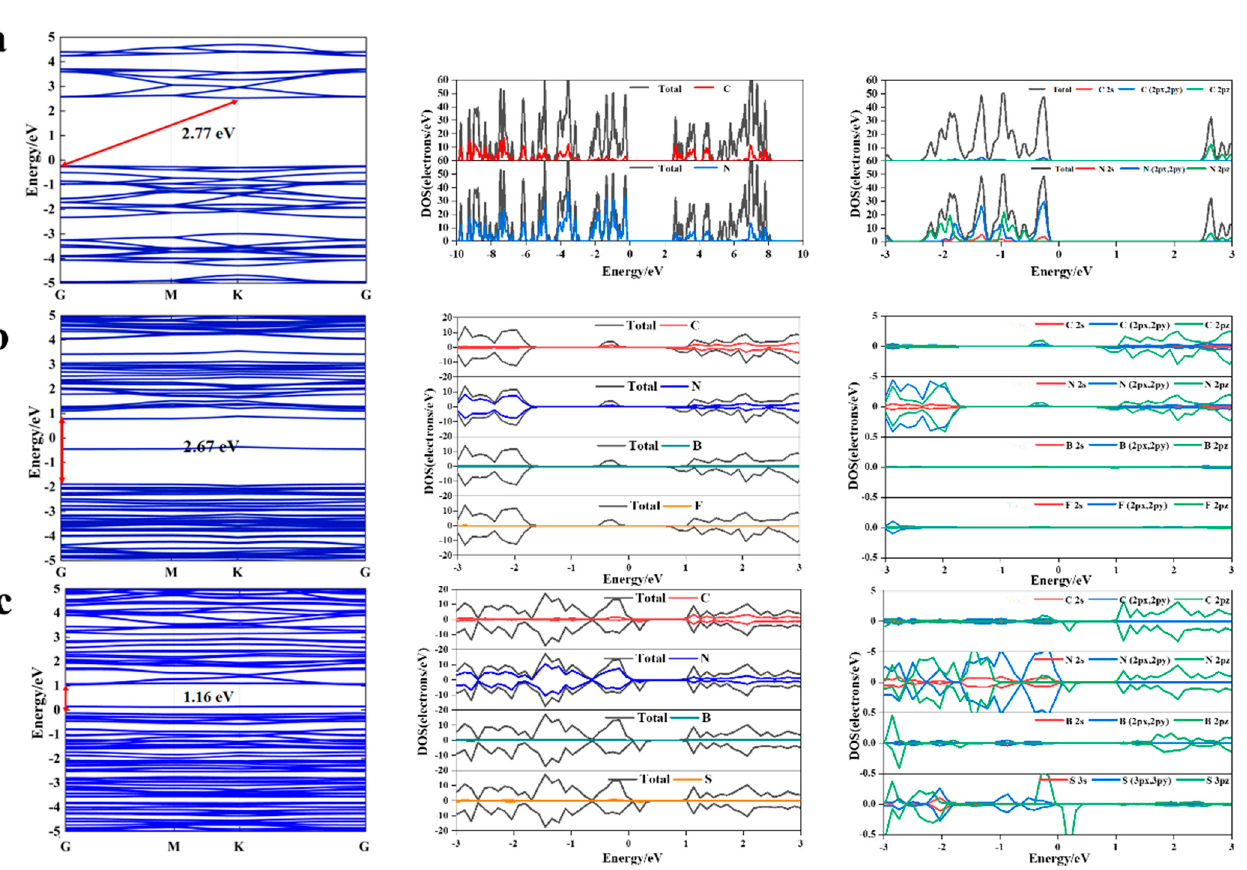
Figure 3. Calculated band structure ( left ), density of states ( middle ), and partial density of states ( right ) diagrams of g-C 3 N 4 ( a ), B-F-N v ( b ), and B-S-N v ( c ).